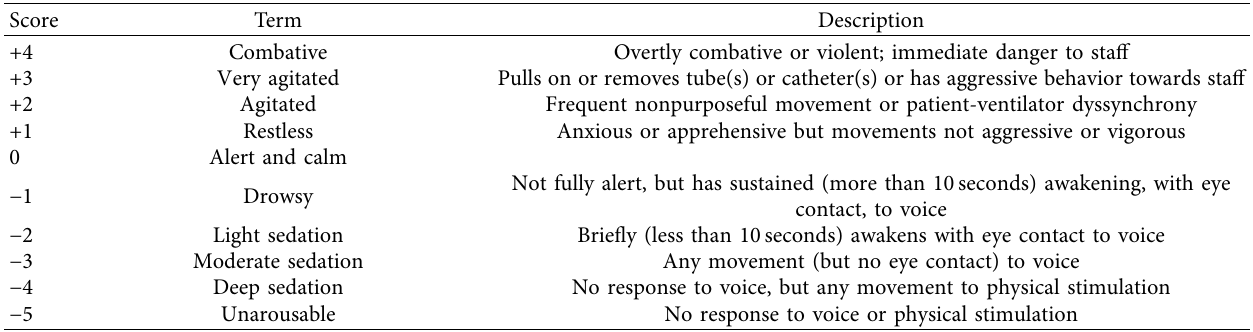
Table 2: Richmond Agitation-Sedation Scale.